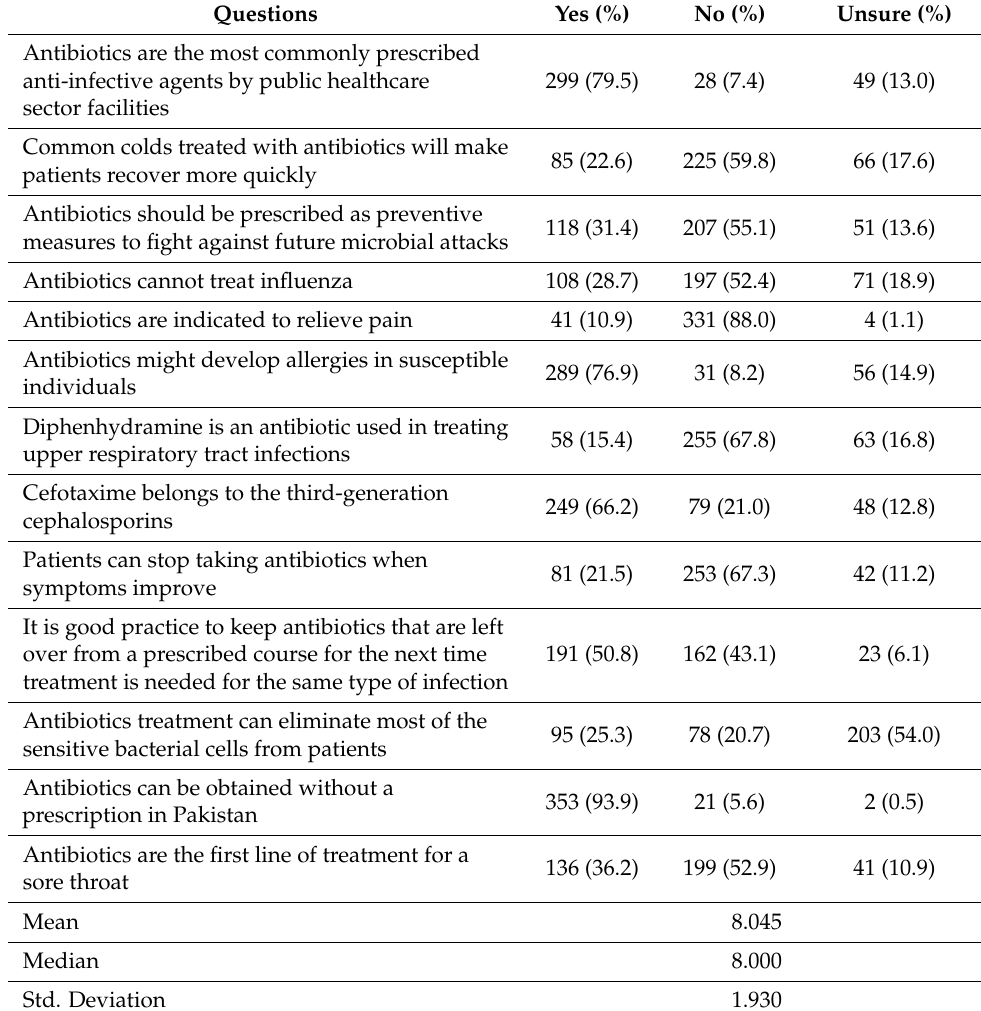
Table 2. Understanding of pharmacy technicians about antibiotic use (n =